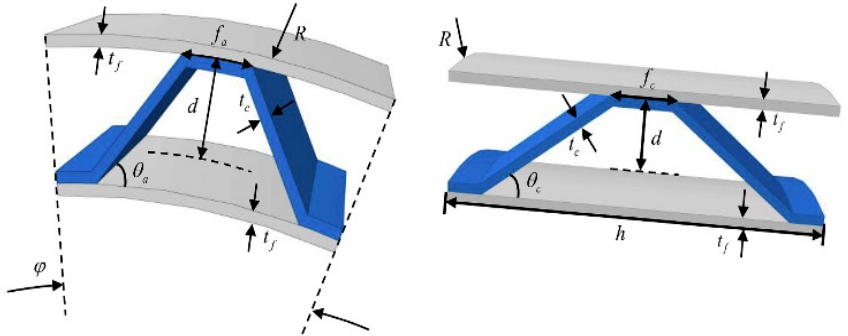
Figure 4. Illustration of a unit cell sandwich core support structure for curved and flat plates [48] (reproduced with permission from Yang et al. Polymer Testing; published by Elsevier, 2018).